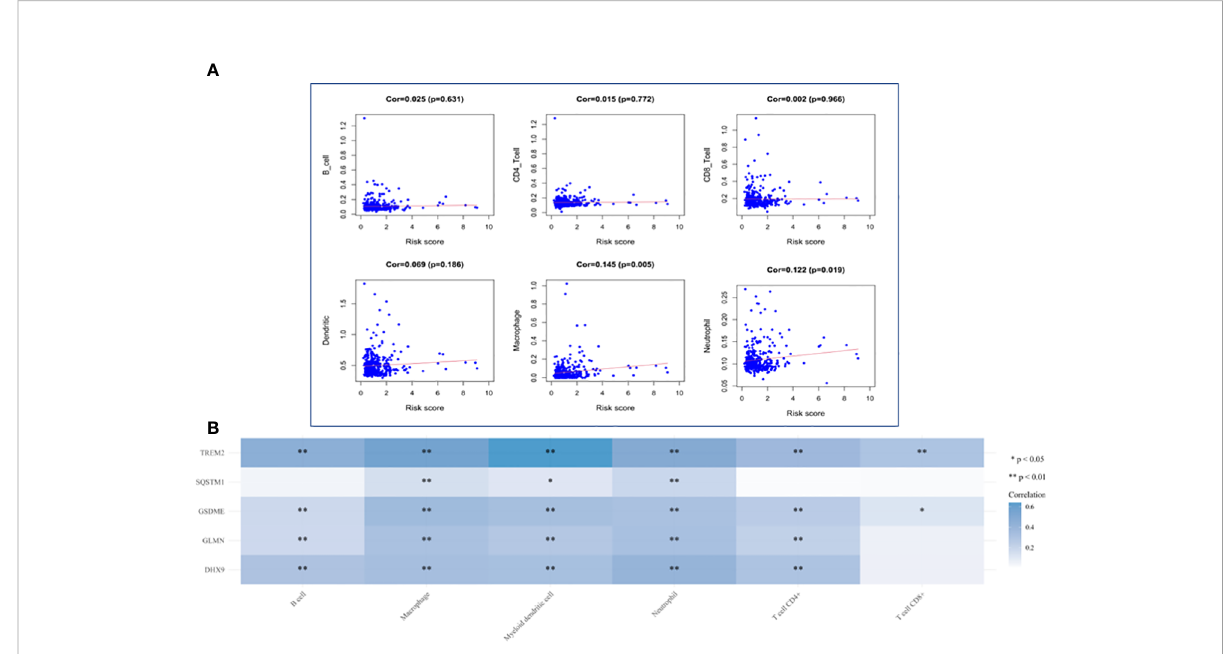
FIGURE 12 Analysis of Immune Cell In fi ltration. (A) Correlation plot between risk score and immune cells in fi ltration. The abscissa represents risk score, the ordinate represents in fi ltration abundances of immune cells. (B) A heat map of the relationship between fi ve risk genes and immune cell in fi ltration. Different colors represent the correlation coef fi cient, and the darker the color is, the stronger the correlation is, *p < 0.05, **P < 0.01, and the asterisk represents the degree of importance